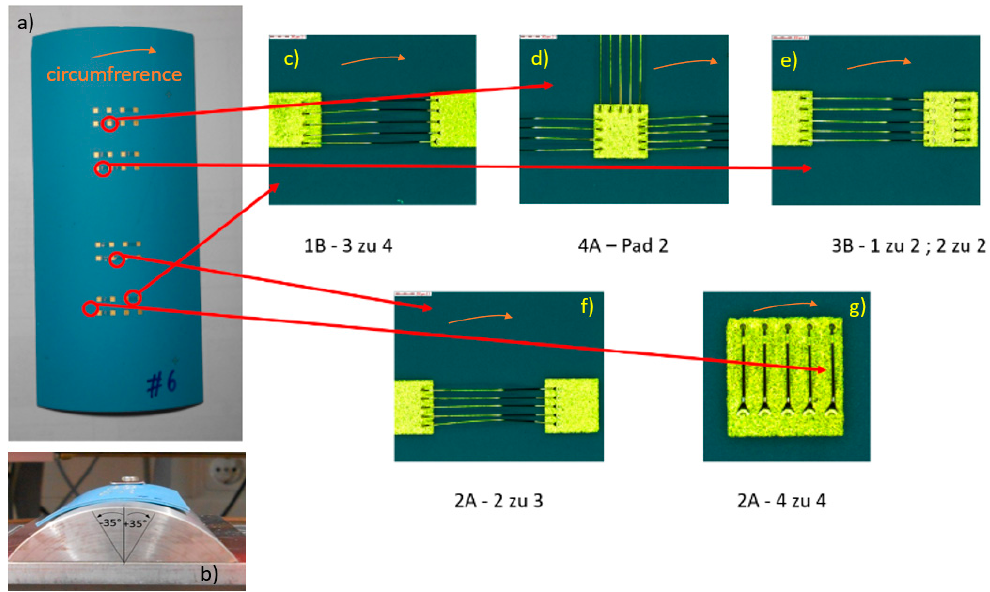
Figure 9. Convex test substrate for wire bonding: ( a ) position of the landing pads; ( b ) limiting angle for successful bonding; ( c – g ) details of the obtained bond connections.